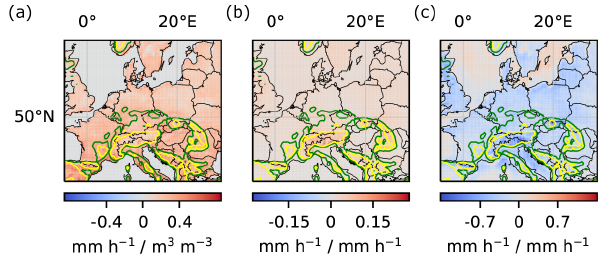
Figure A8. Local soil-moisture–evaporation and local and regional evaporation–precipitation couplings. (a) Local soil-moisture– evaporation coupling. (b) Local evaporation–precipitation coupling. (c) Regional evaporation–precipitation